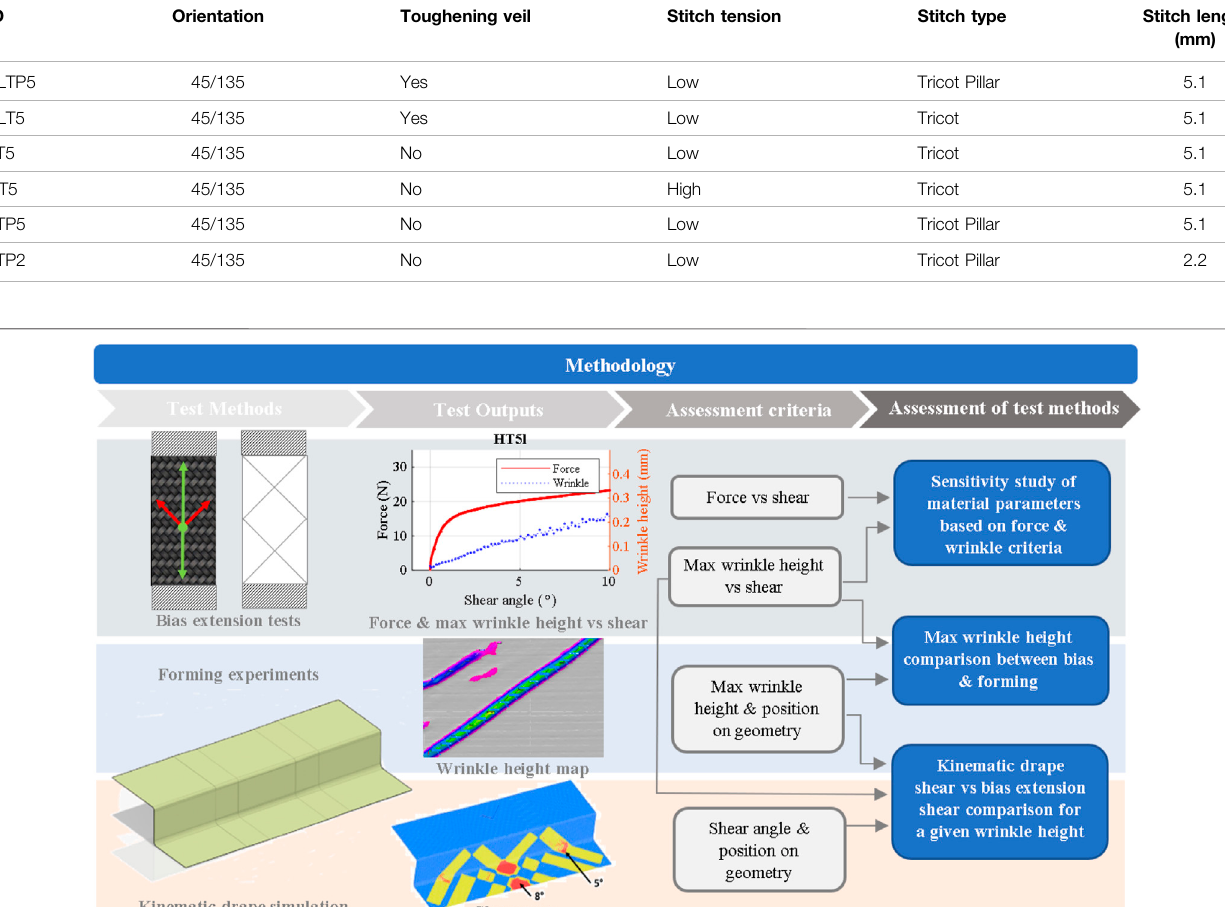
TABLE 1 | Material formats tested in forming and bias extension tests, with parameter change between adjacent rows highlighted.